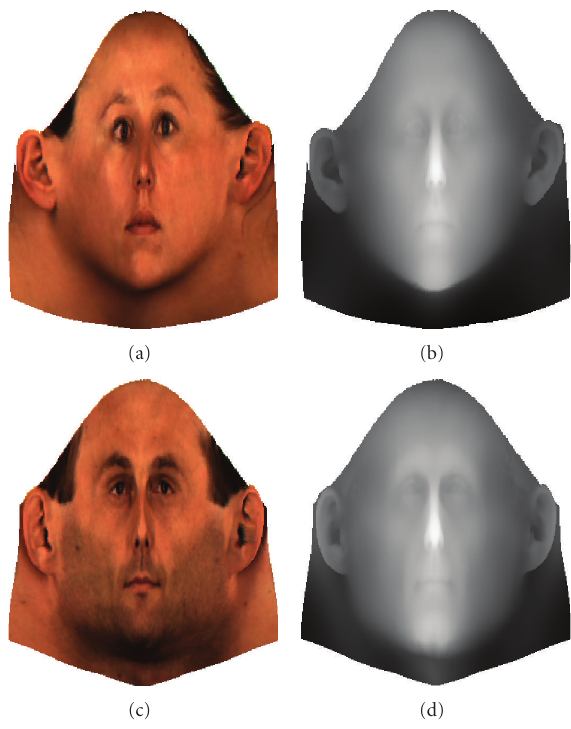
Figure 4: The texture and height mapping images for optical flow computation. The top two are the texture and height mapping images of the source 3D face. The bottom two are the texture and height mapping images of the destination 3D